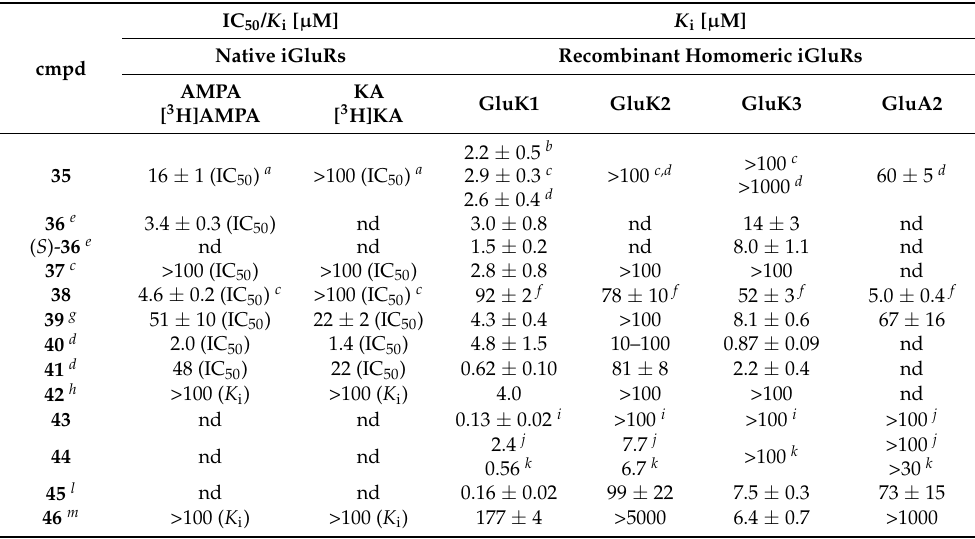
Table 6. Receptor binding affinity of selected α -amino acids antagonists at native and recombinant homomeric iGluRs, determined in radioligand binding assays (all values in µ